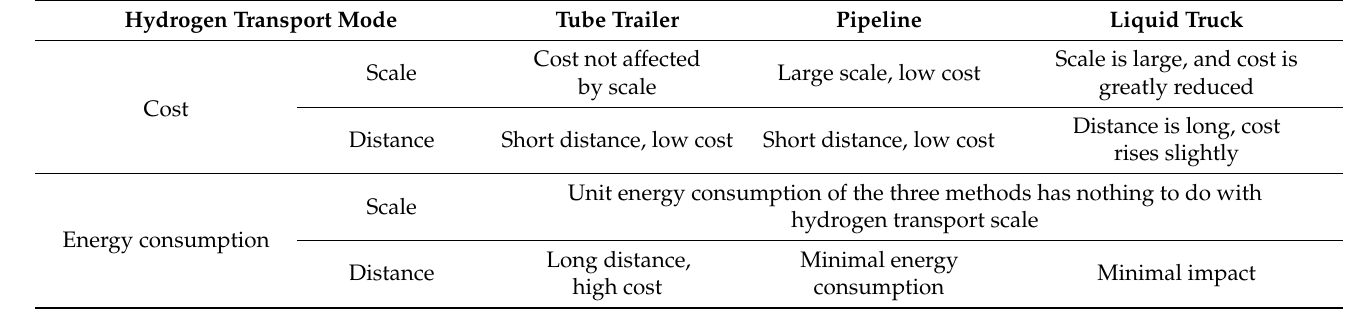
Table 3. Comparison of scale, cost, and energy consumption of three modes of hydrogen transport